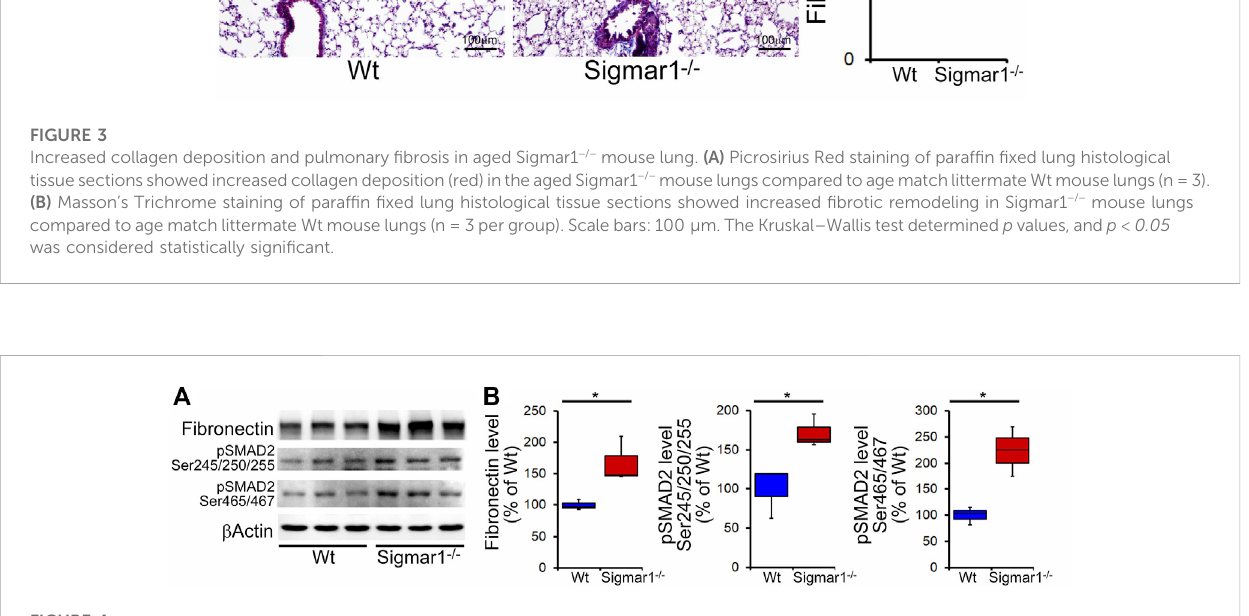
(Figure 5). The Sm lining around the B in Sigmar1 − / − lungs showed